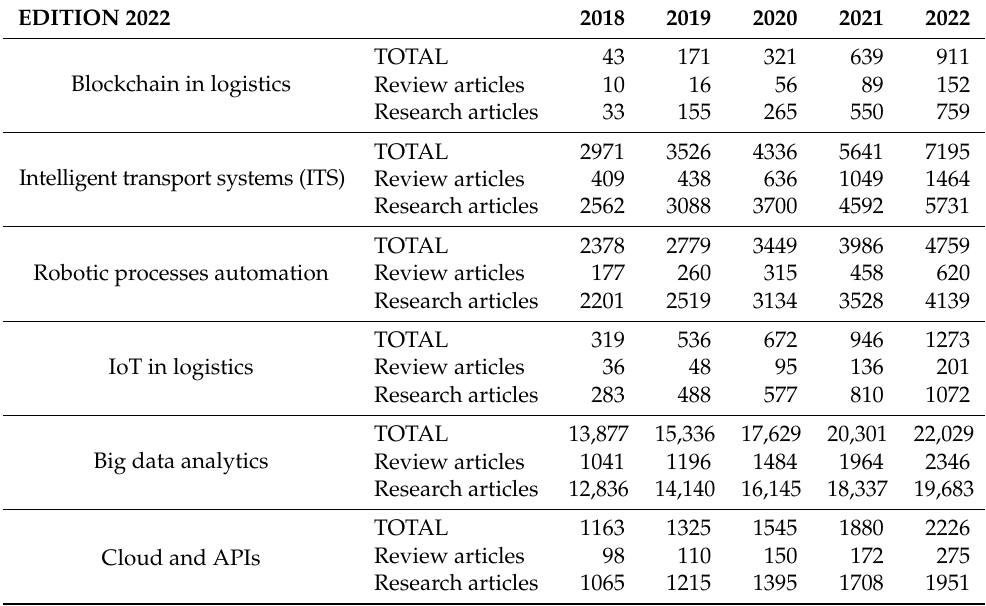
Table 2. Analysis of the degree of research interest in innovative solutions (ScienceDirect database, December